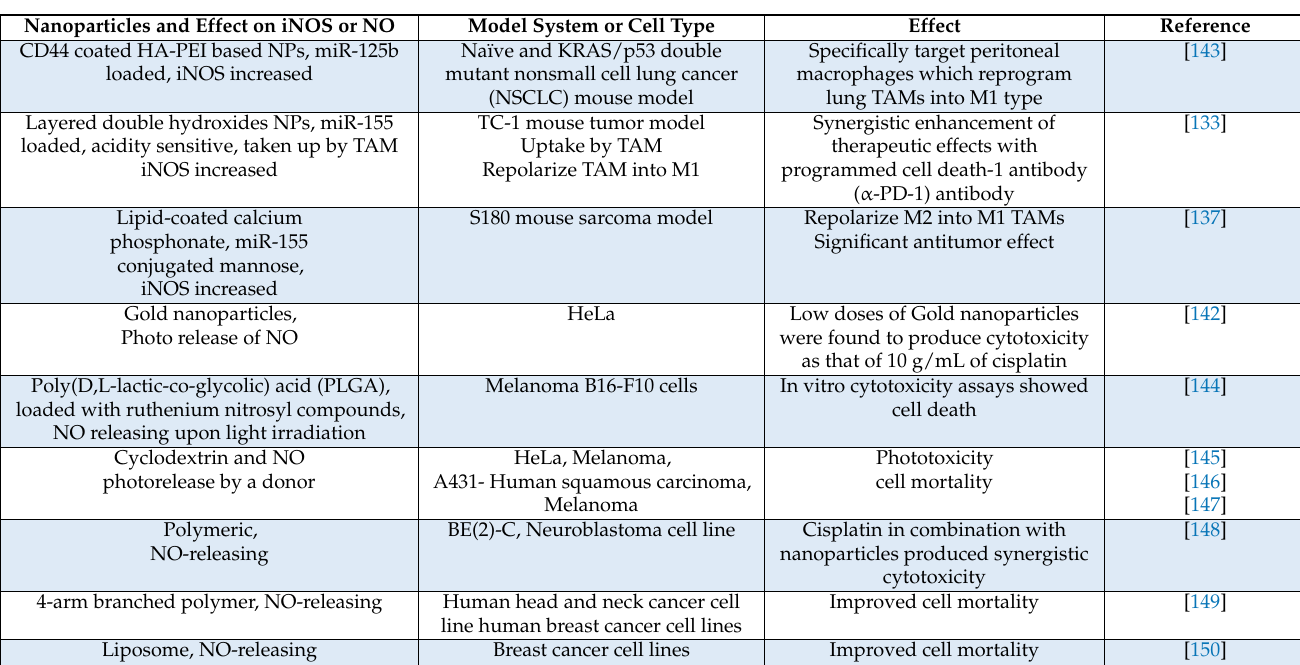
Table 1. Nanoparticles releasing NO or inducing iNOS and effect on macrophages or TAM. Nanoparticles and Effect on iNOS or NO